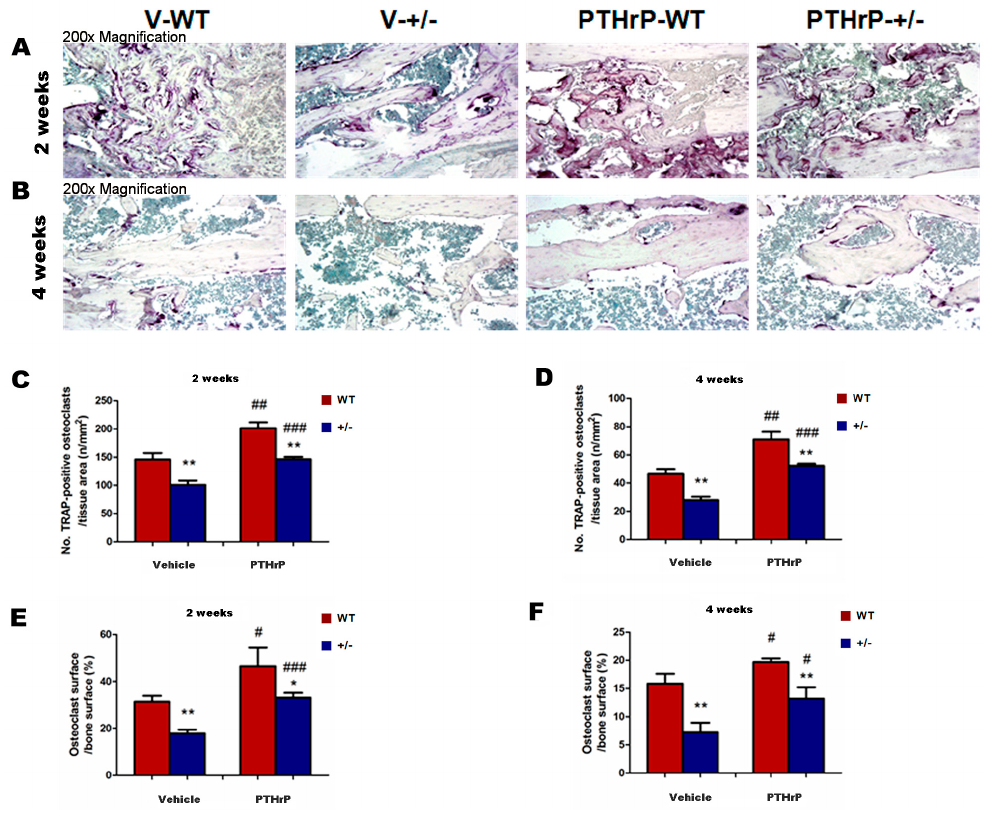
Figure 5. Exogenous PTHrP’s effects on osteoclastic bone resorption in calluses at two and four weeks PF. Representative micrographs of callus sections from Vehicle (V)-WT, V-KO, PTHrP-WT, and PTHrP-KO mice stained histochemically for tartrate-resistant acid phosphatase (TRAP) ( A , B ). Number of TRAP-positive osteoclasts related to tissue area ( C , D ) and osteoclast surface relative to bone